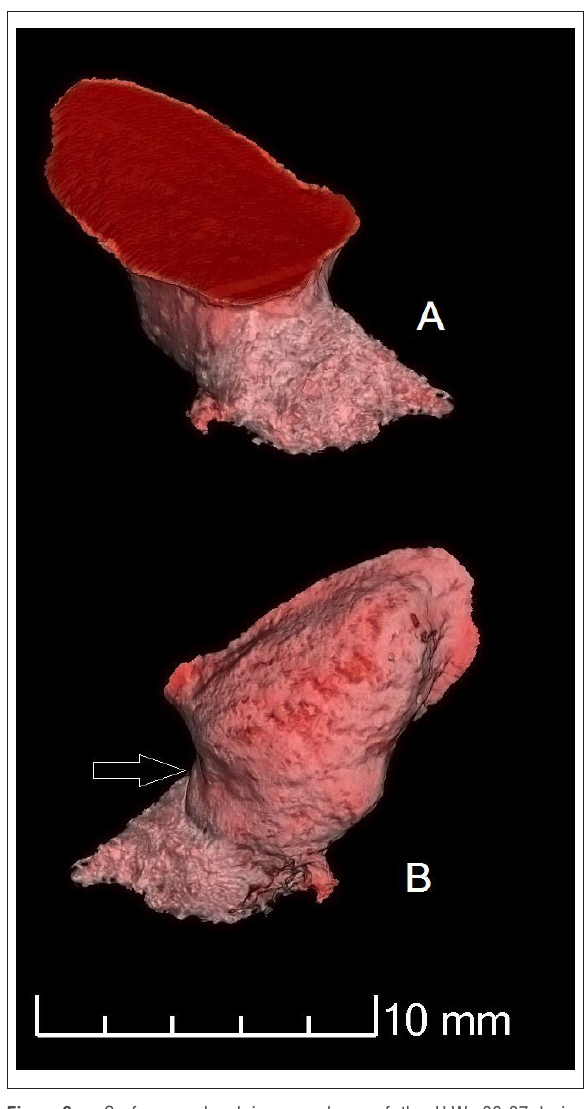
Figure 6: Surface rendered image volume of the U.W. 88-37 lesion derived from phase-contrast X-ray synchrotron microto- mography. Images show isosurface derived from segmented boundaries of the lesion (remaining breccia infill removed). The arrow denotes the interface between the smoother dorsal sclerotic zone and the disorganised ventral lytic zone within the body of the lesion. (a) right lateral view, (b) medial view. Images produced by